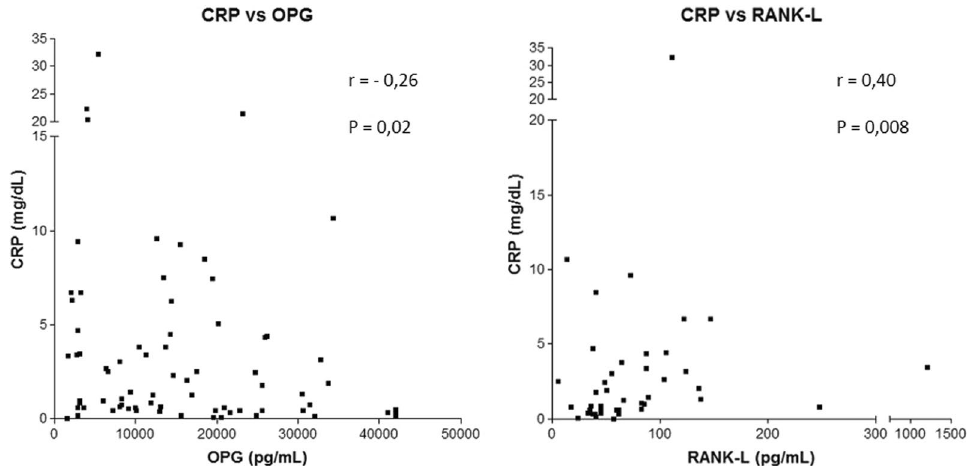
Fig. 2 Correlation between CRP and the levels of OPG and RANKL for the 83